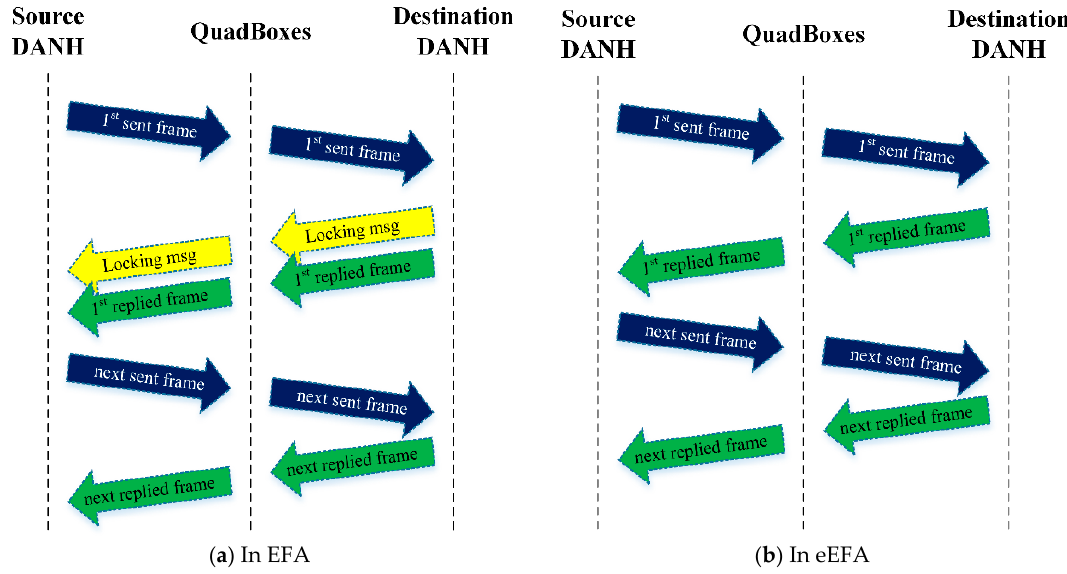
Figure 8. Process of forwarding frames between the source and the destination.